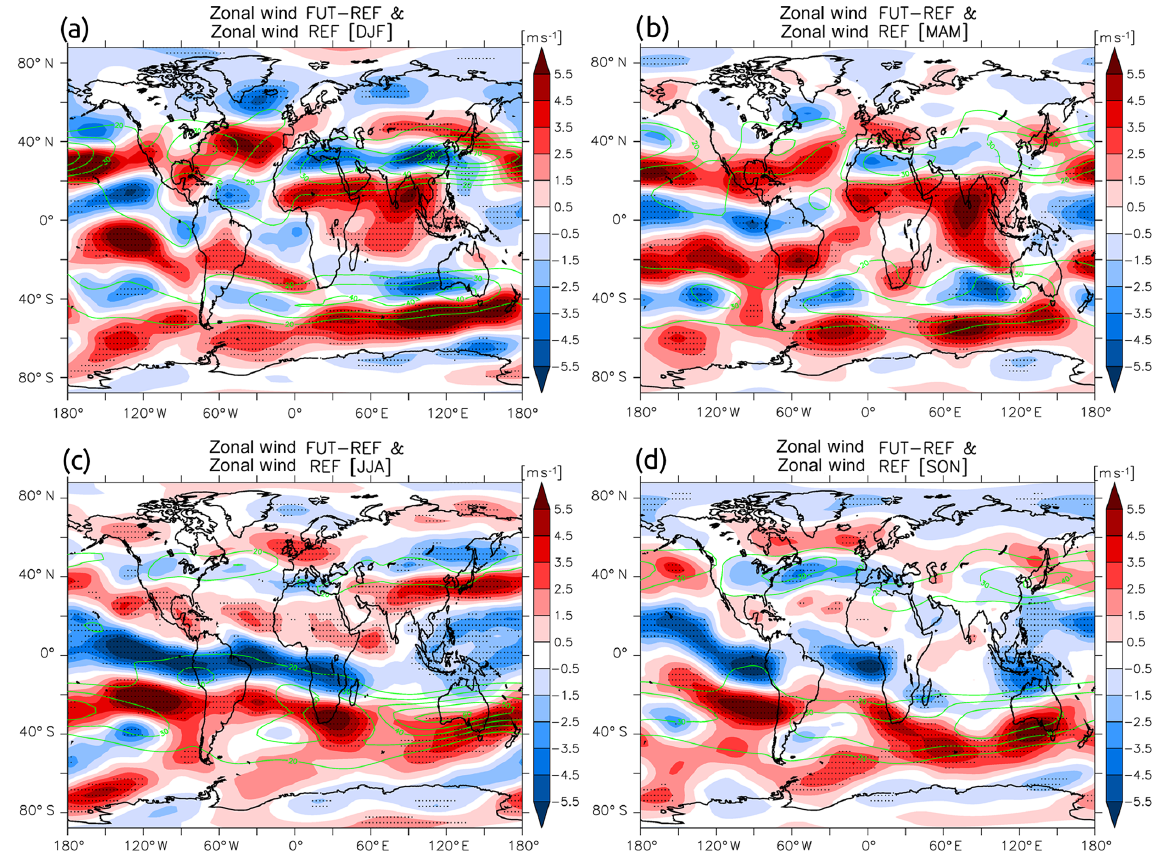
Figure 3. Mean zonal wind differences at 250hPa (shaded; ms − 1 ) between the FUT and REF periods for DJF (a) , MAM (b) , JJA (c) , and SON (d) . The green contours represent the mean zonal wind at 250hPa (ms − 1 ) during the REF period. The regions where the changes are statistically significant at the 99% confidence level are hatched with black